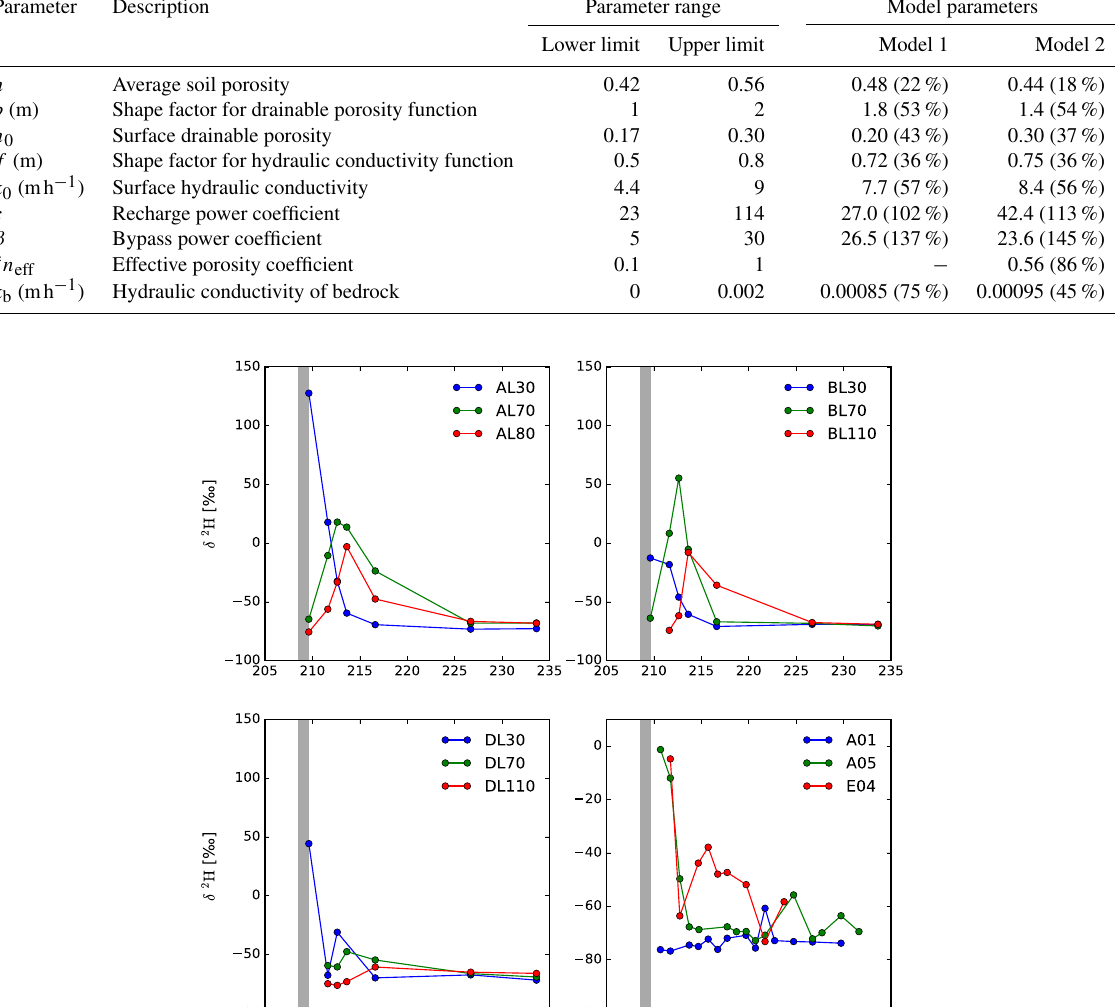
Table 3. Parameter description, ranges (calibration) and best parameter sets with uncertainty in parentheses based on lateral subsurface flow (Model 1) and based on both lateral subsurface flow and δ 2 H (Model 2). Parameter uncertainty is defined as the range between behavioral parameter values of the 0.1 and 0.9 percentiles divided by the median parameter value expressed as a percentage.